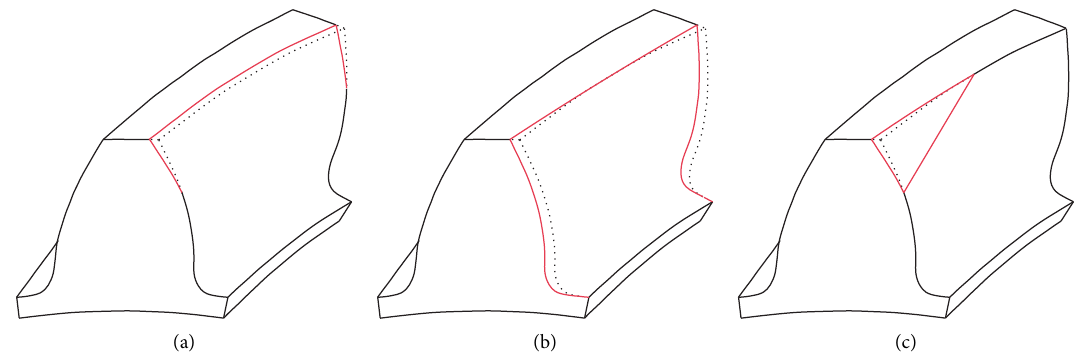
Figure 1: Three types of tooth surface modification methods for helical gear pairs.